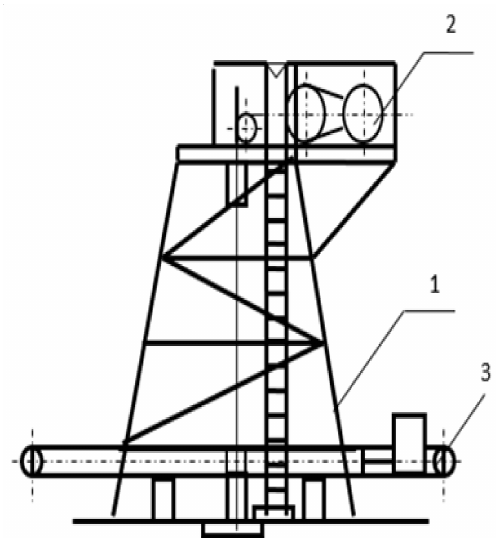
Figure 3. Schematic of the original design of the test equipment: (1) tower; (2) drop hammer lifting winch; (3) belt conveyor